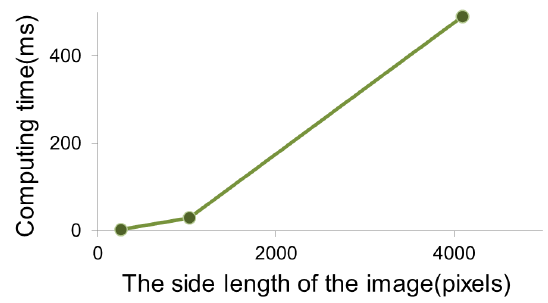
Figure 10. The relationship between the size of the image and the total data preprocessing time.